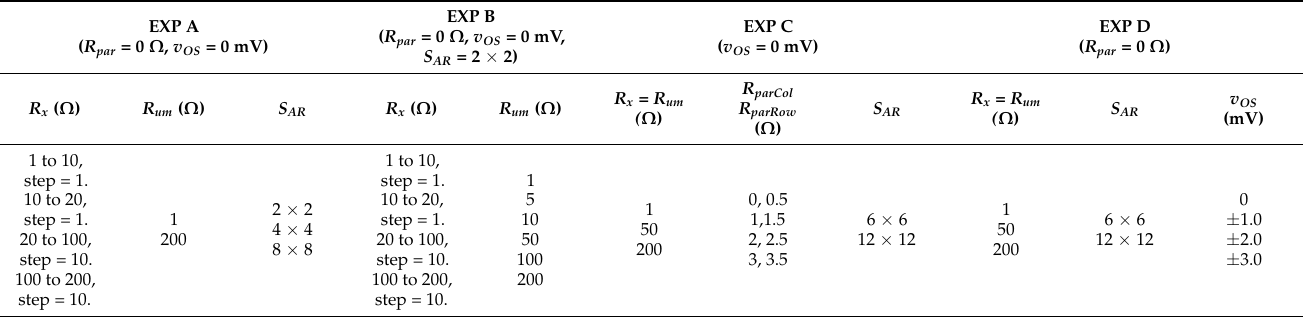
Table 1. Experiments setup for DZCM with selected